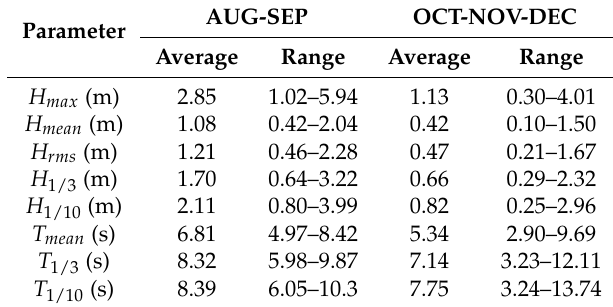
Table 1. Seasonal variability of wave characteristics observed in offshore Salalah.